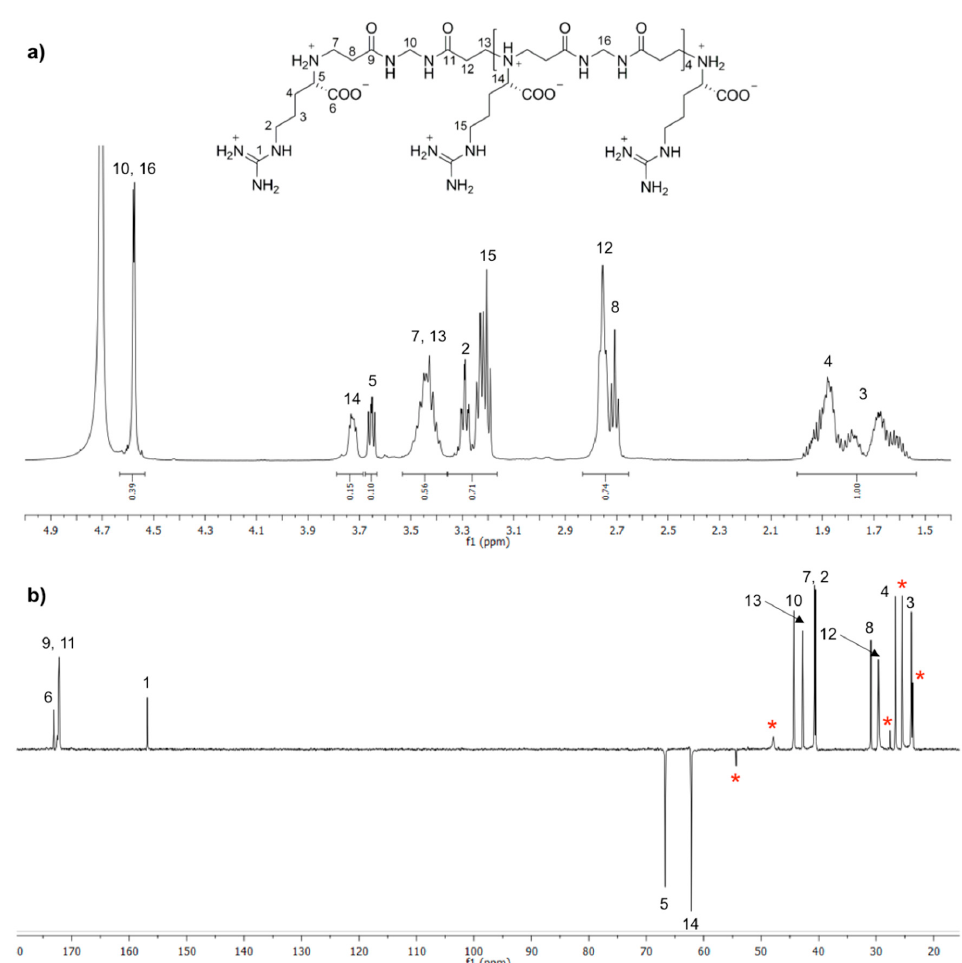
Figure 1. 1 H NMR ( a ) and 13 C APT NMR ( b ) spectra of ArMArMArMArMArMAr recorded in D 2 O/DCl at pH = 4.5. * Differently protonated species.